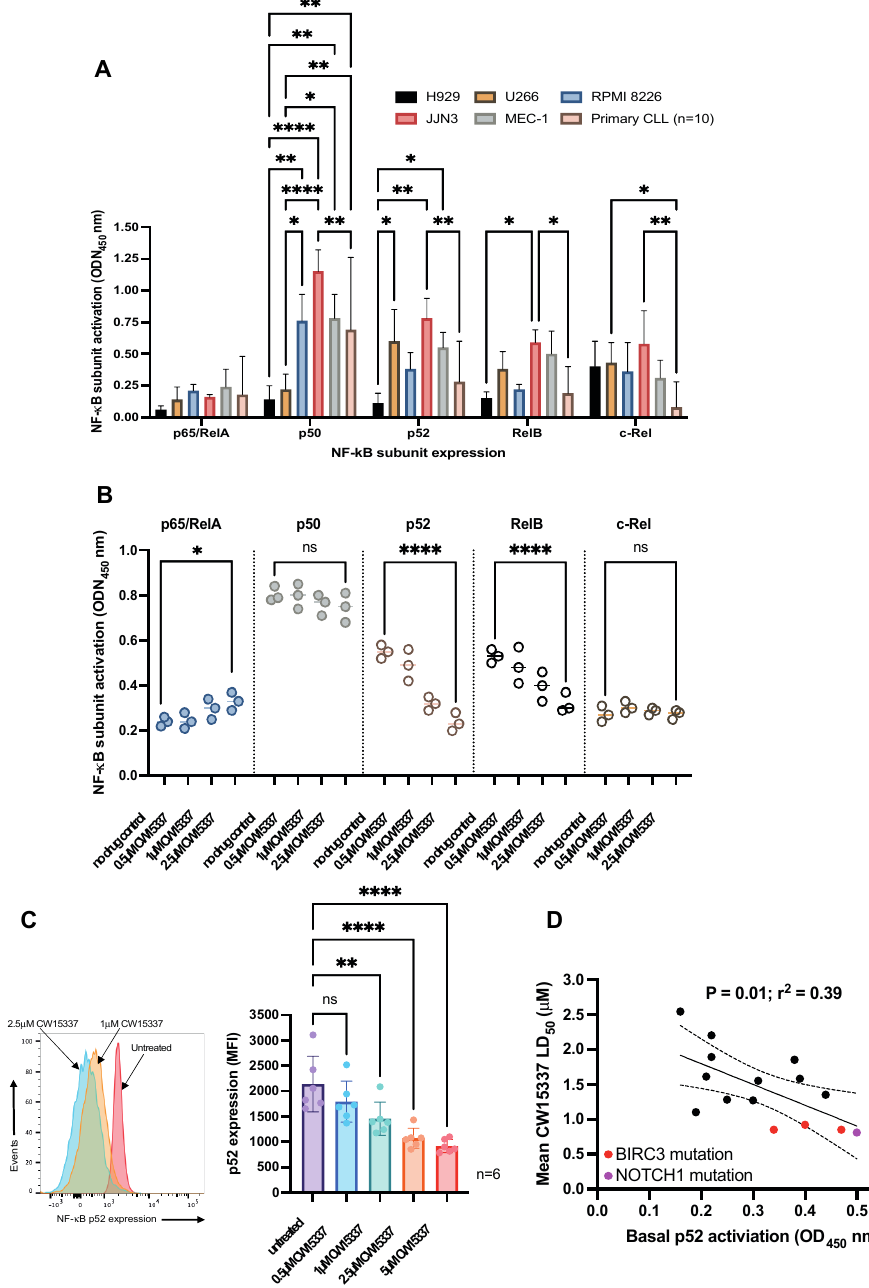
Figure 3. CW15337 preferentially inhibits the nuclear expression of p52 and RelB NF- κ B subunits. ( A ) Each cell line evaluated showed a distinct pattern of constitutive NF- κ B subunit activation in nuclear extracts. ( B ) Exposure to CW15337 resulted in a concentration-dependent reduction in two non-canonical NF- κ B subunits, p52 and RelB. ( C ) MEC-1 cells treated with increasing concentrations of CW15337 showed a marked inhibition of p100 processing to p52. ( D ) Constitutive p52 expression in nuclear extracts from primary CLL samples ( n = 15) were correlated with in vitro sensitivity to CW15337. **** p < 0.0001, ** p < 0.01 and * p < 0.05. ns = not